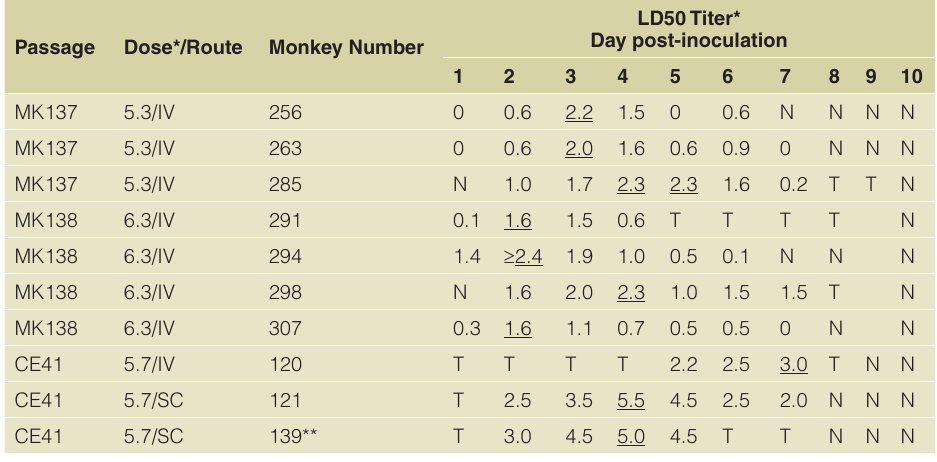
Table 4. Infection and mortality in the bonnet macaque with TC-adapted KFDV. * Positive logarithms of adult mouse LD50 titers/0.03 ml.